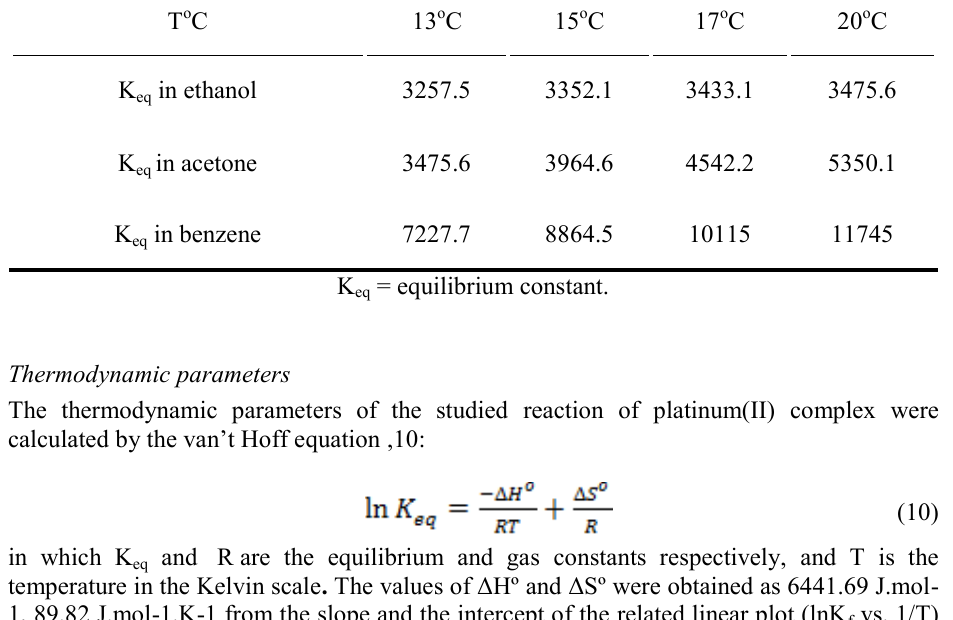
H NO at different 5 5